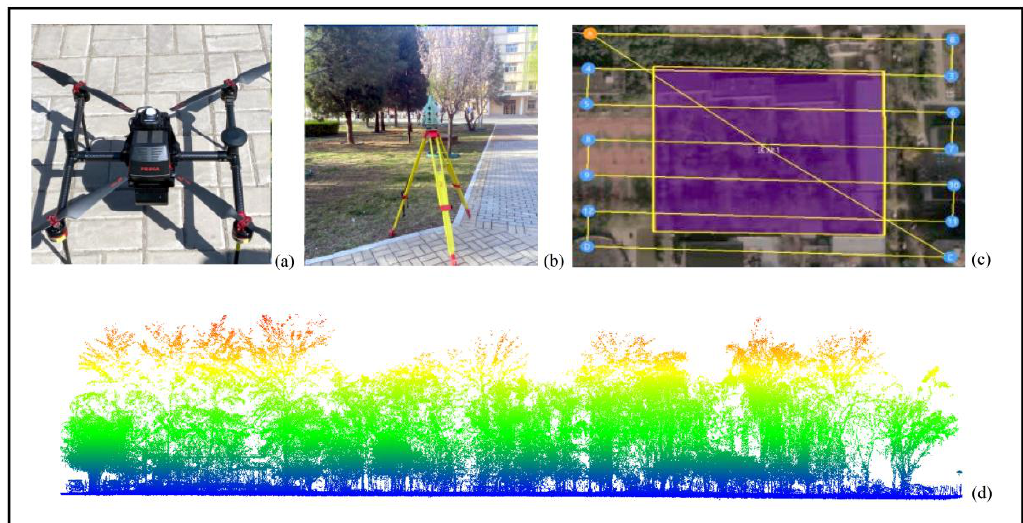
Figure 2. ( a ) The UAV, ( b ) The total station with the scanning mode, ( c ) The flight plan and ( d ) Point cloud image.